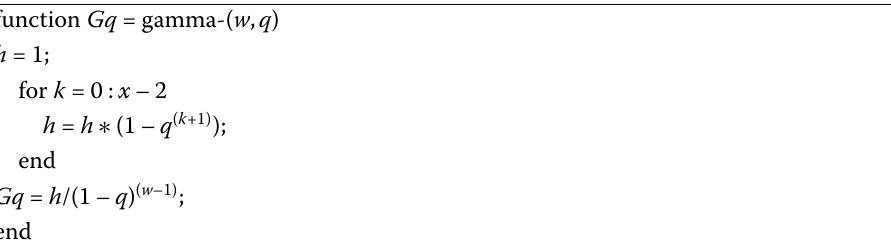
Algorithm 1 The proposed procedure to calculate (cid:6) q ( w )